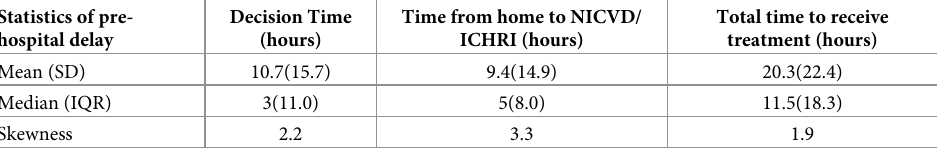
Table 2. Total pre-hospital delay, decision time and time from decision to reach hospital